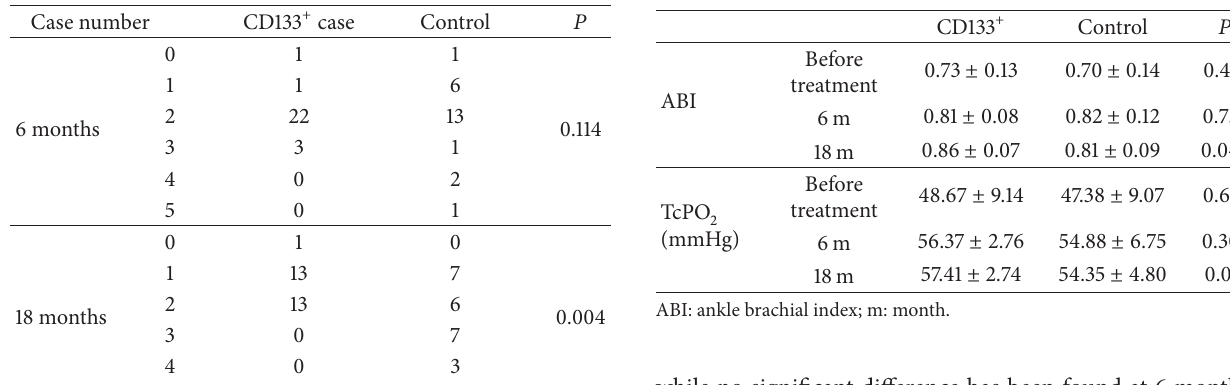
Table 2: Rutherford classification after treatment. Table 3: ABI and TcPO 2 before and after